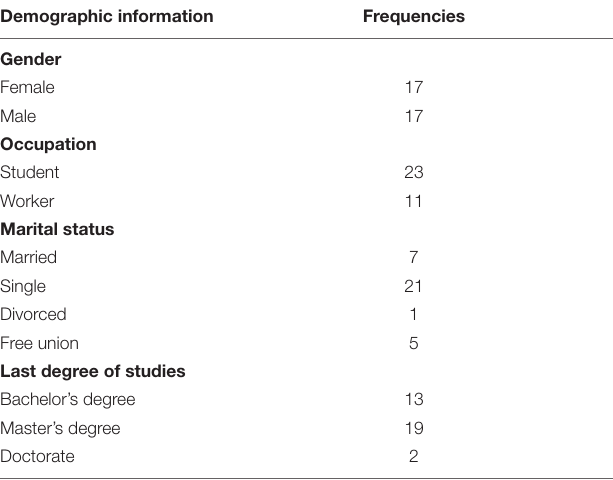
TABLE 1 | Participant’s demographic